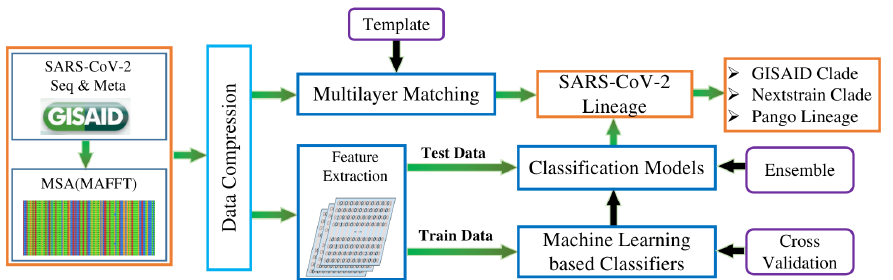
Figure 1. Processing pipeline of the SARS-CoV-2 genome sequence typing system. The system mainly includes data acquisition and preprocessing, multiple sequence alignment, data compression and feature extraction, supervised model training, and model testing. The ensemble model can achieve three different genome sequence typing predictions (GISAID, Nextstrain, and Pangolin). Templates can be obtained from the training set, and the Nextstrain or GISAID clade of the testing SARS-CoV-2